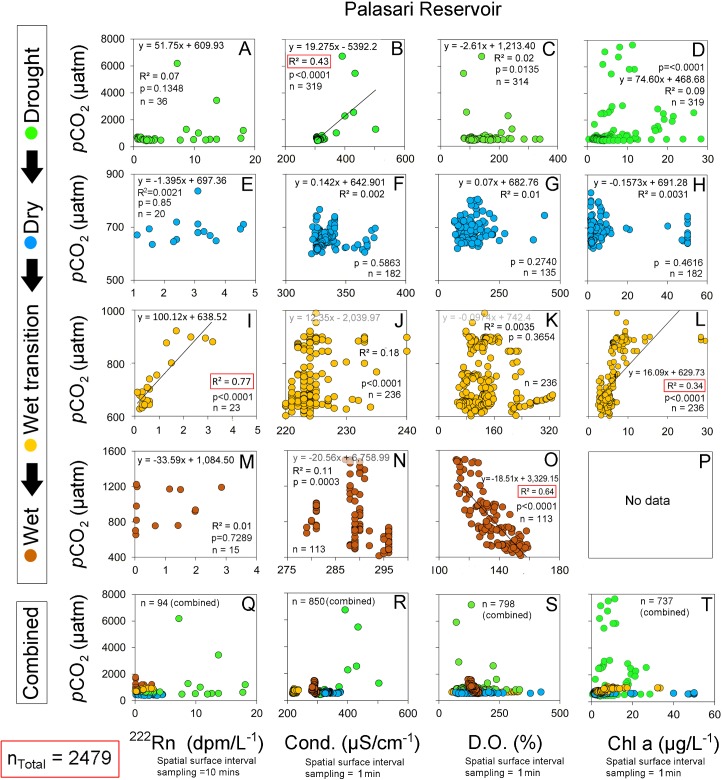
Relationships between pCO2 and 222Rn (groundwater tracer), conductivity, dissolved oxygen and chlorophyll a (from left to right) in reservoir (Palasari Reservoir).